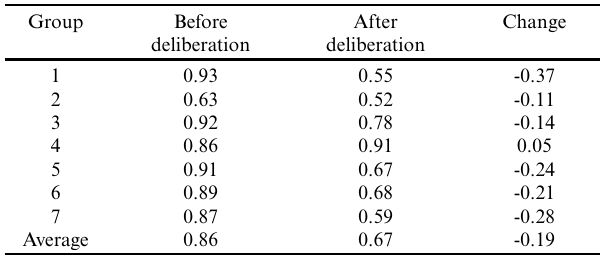
Table 3 . Standard deviations between members of each group in ecosystem service rankings, averaged across ecosystem services.